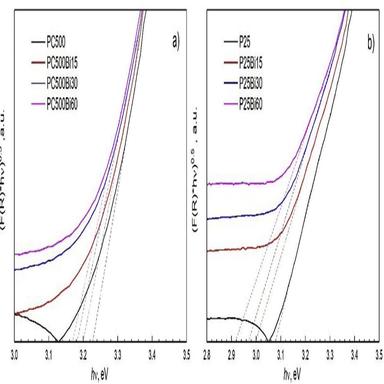
Band gap calculation using Kubelka-Munk function: a) PC500-based samples; b) P25-based samples.